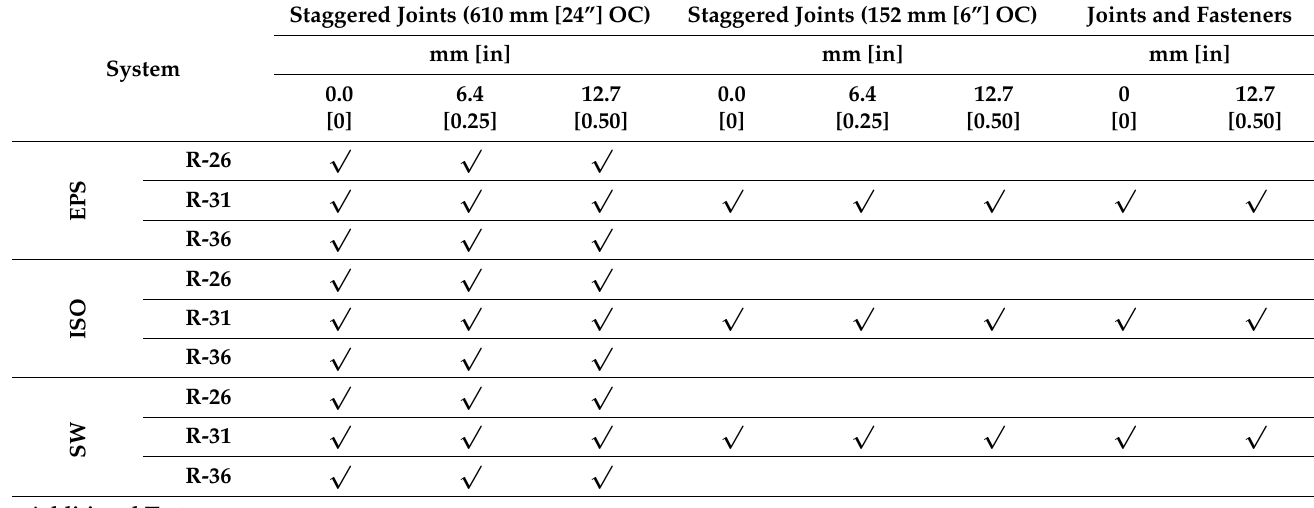
Table 2. Test Matrix for Testing on Insulation